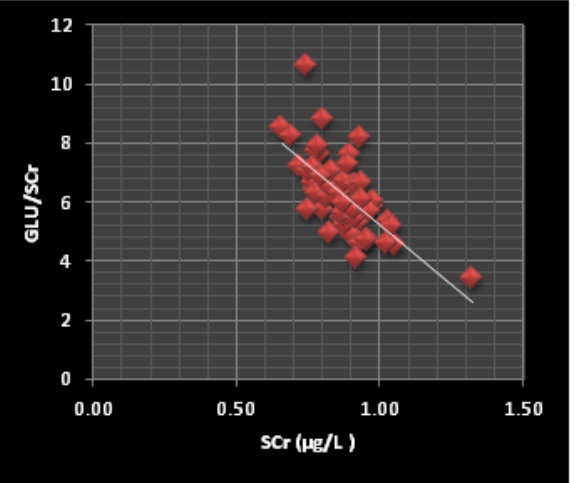
Figure 1. The correlation between the SCr levels and the Glu/SCr ratio in ThPP workers (r = − 0.67, p <